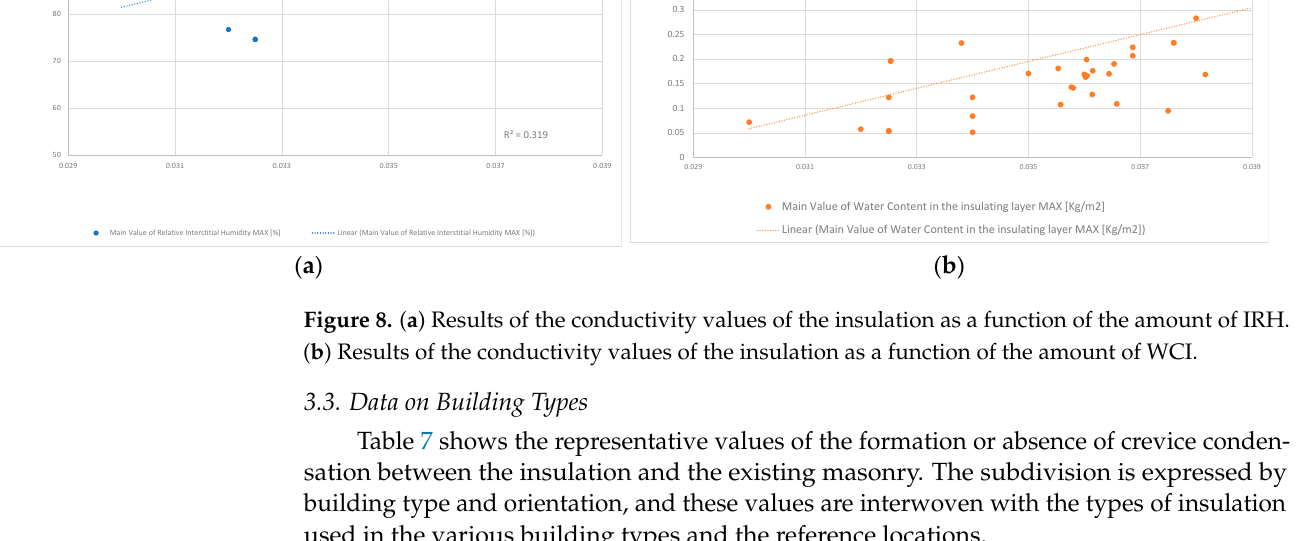
Figure 7. ( a ) Results of the values of the vapour permeability coefficient of the insulation as a function of the amount of IRH. ( b ) Results of the values of the vapour permeability coefficient of the insulation as a function of WCI. The dispersion graphs in Figure 8 represent: (a) the trend of the values relative to the conductivity of the materials in function of the quantity of IRH, where, in abscissae, the values relative to the conductivity (W/mK) are reported, while in ordinate, the values in percentage of the quantity of humidity are shown, and (b) the same trend, however, in ordinate, the quantity of water inside the insulation is reported.